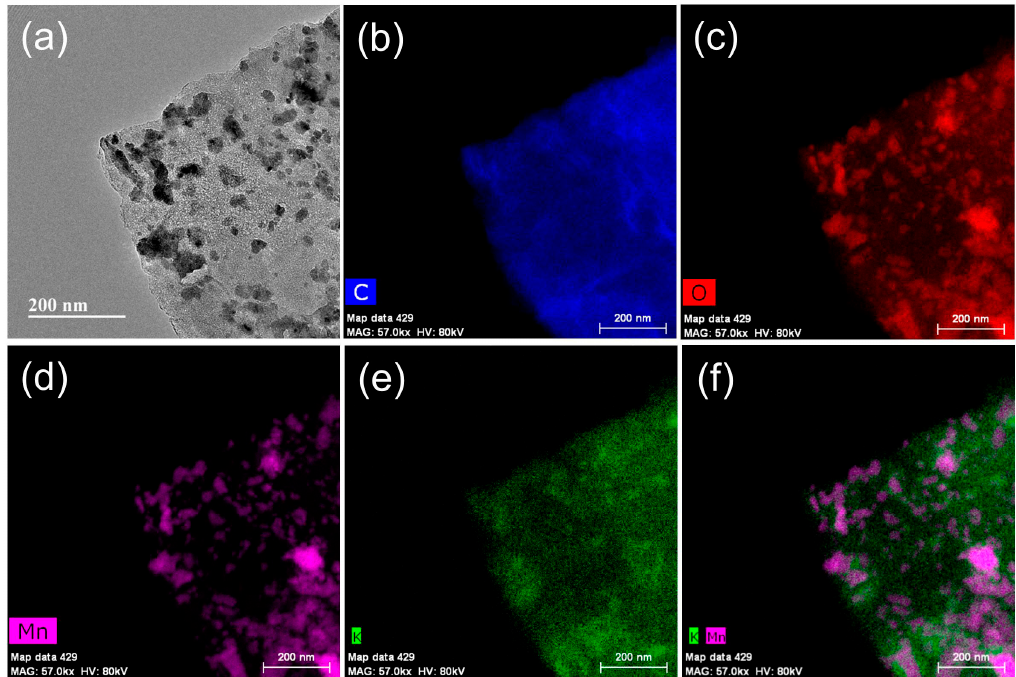
Figure 3. Energy dispersive spectroscopy (EDS) analysis of GM 500 with TEM. ( a ) TEM image of GM 500 , elemental maps of ( b ) C, ( c ) O, ( d ) Mn, and ( e ) K, and the ( f ) Mn-K composite image.